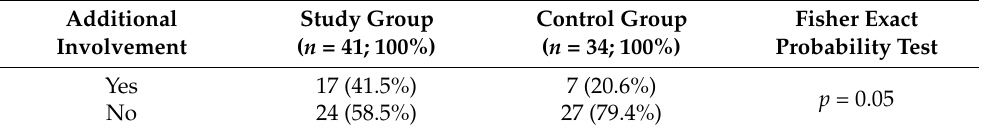
Table 10. Did the feeding require any additional involvement of the caregiver, such as playing with the child, diverting the child’s attention from food? (question